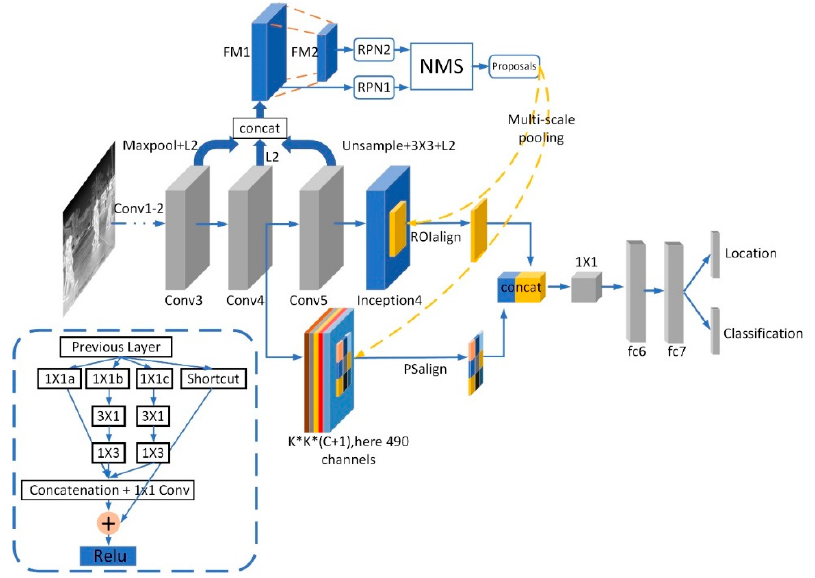
Figure 1. The complete structure of our frame.